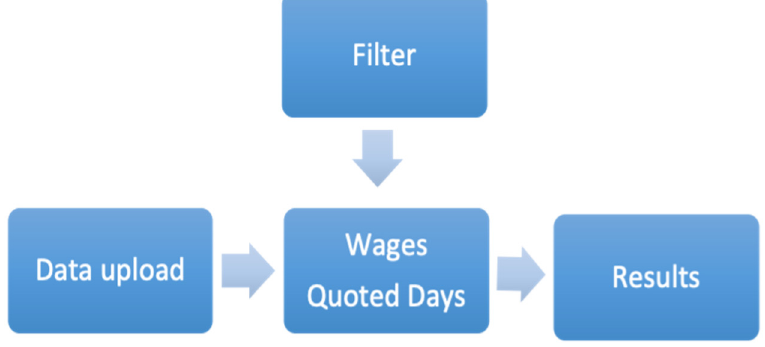
Figure 1. Simplified flow chart of code 1 execution . Source: our own elaboration.